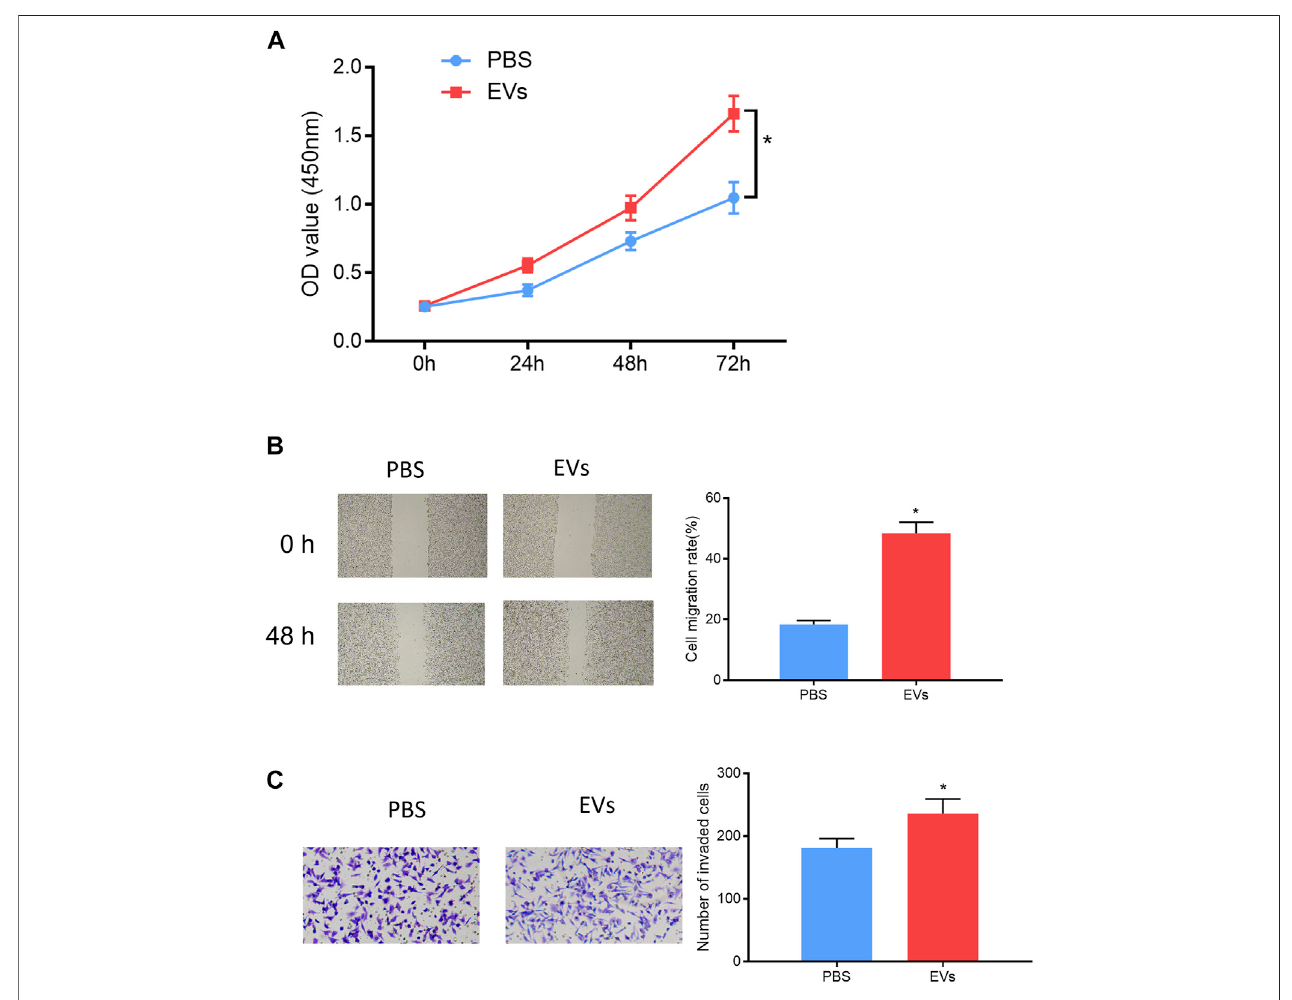
FIGURE 7 | Serum EV-derived miRNA-105-5p of ESCC patients accelerates cell processes. (A – C) CCK-8 assay (A) , wound healing assay (×40), / (B) and Transwellinvasionassay(×100) (C) wereperformedtoevaluateESCCcellproliferation,migration,andinvasionafterESCCcellswereco-culturedwithPBSorserumEVs of ESCC patients, respectively; * p <